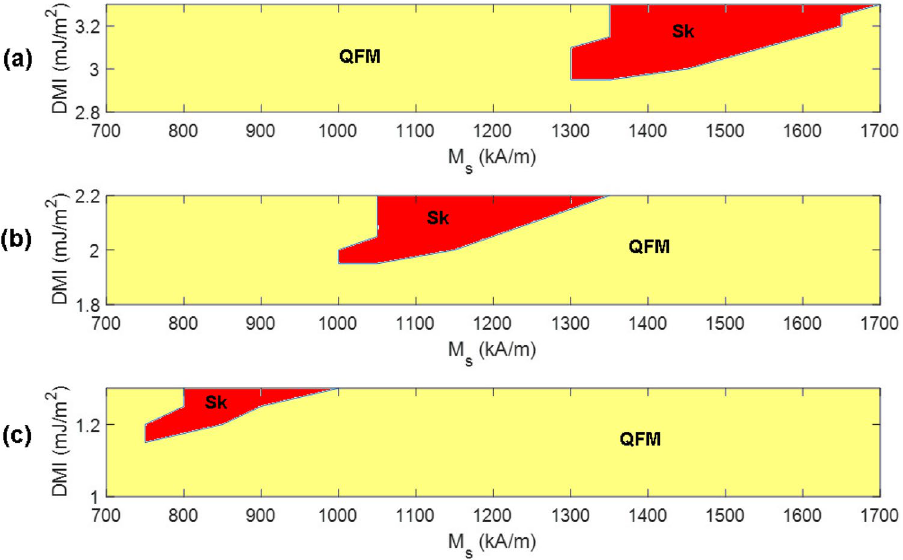
Figure 2. DMI-M s phase diagram for ( a ) 20 nm, ( b ) 30 nm and ( c ) 50 nm (QFM and Sk in the phase diagrams represent the regions where quasi-ferromagnetic and skyrmion states are